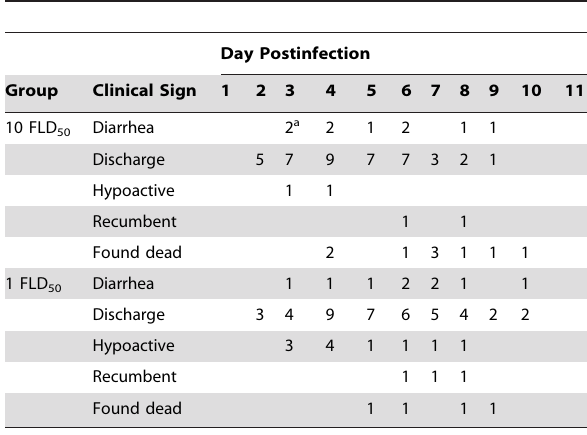
Table 1. Clinical observations in ferrets infected with H5N1 virus,